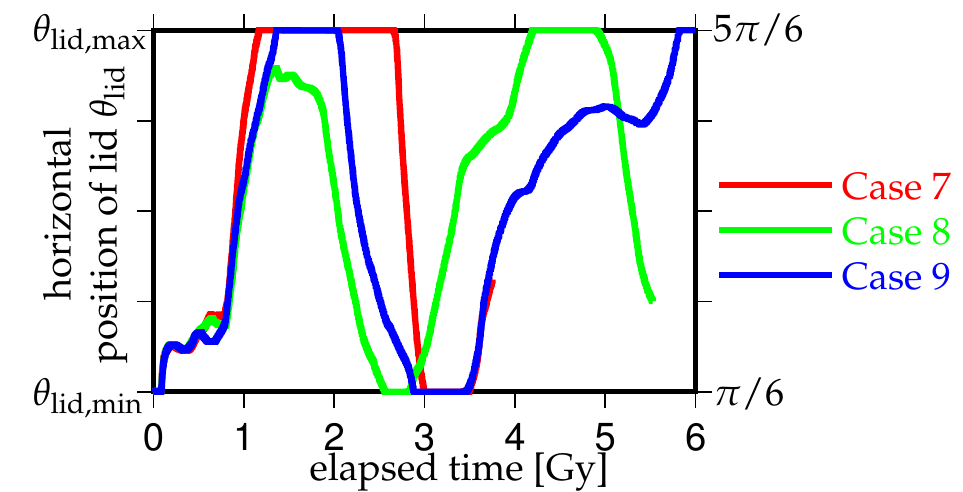
Figure 12. Same as Figure 2, but for Cases